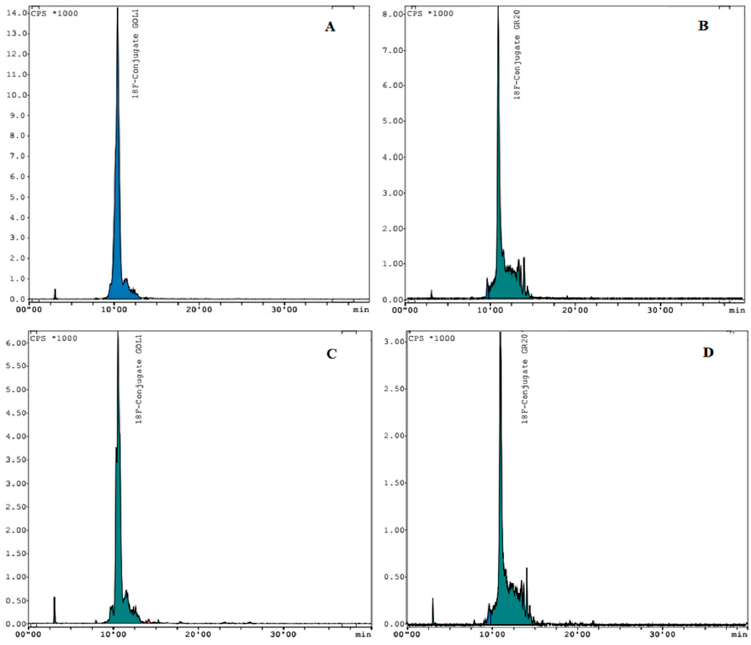
Figure 4. Click reaction with the TBTA ligand. HPLC profiles of precipitated GOL1 conjugate (( A )—immediately after conjugation and ( C )—after 2 h) and precipitated GR20 conjugate (( B )—immediately after conjugation and ( D )—after 2 h). Conditions: Phenomenex Luna C18 column (5 µ m, 4.6 × 250 mm); mobile phase: linear gradient: starting with 100% eluent A (0.1 M triethylammonium acetate in water) and 2% solvent B (acetonitrile) with replacement by 65% eluent A and 45% eluent B at 20 min, flow rate 1 mL/min.